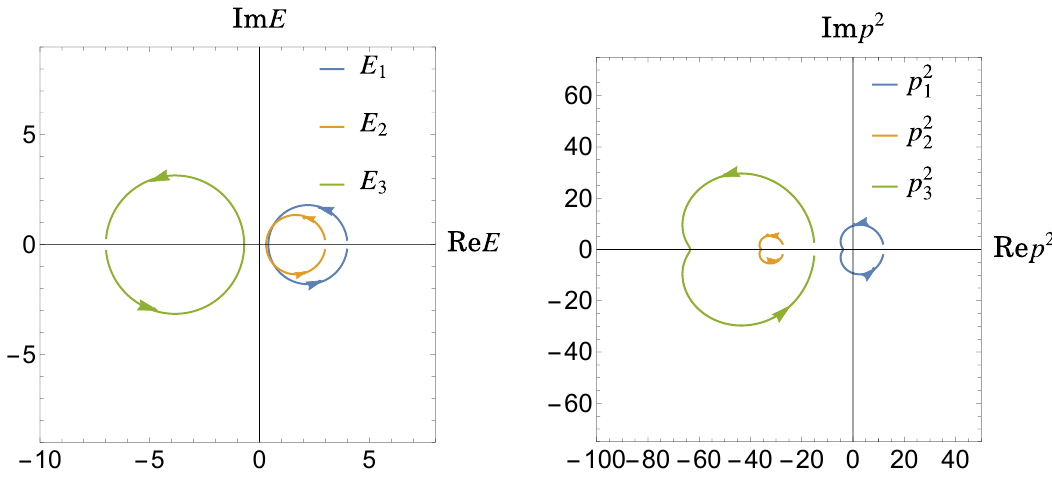
Figure 1 . Example analytic continuation involving three external energies. We start at the kinematic point p 1 = (4 , 2 , 0 , 0) , p 2 = (3 , 6 , 0 , 0) , and p 3 = ( − 7 , − 8 , 0 , 0) , where we have p 2 = 12 , p 2 = − 27 , and p 2 = − 15 . We rotate the energies by E j → [0 . 1 + 0 . 9 e iπs cos( πs )] E j 1 2 3 with 0 ≤ s < 1 . During this rotation the positive invariant p 2 circles its branch point at p 2 = 0 , 1 1 thus taking us from R 1 → R ? → R 1 , but changing the sign of the corresponding iε . The small gaps at the beginning and end of the paths represent the ± iε